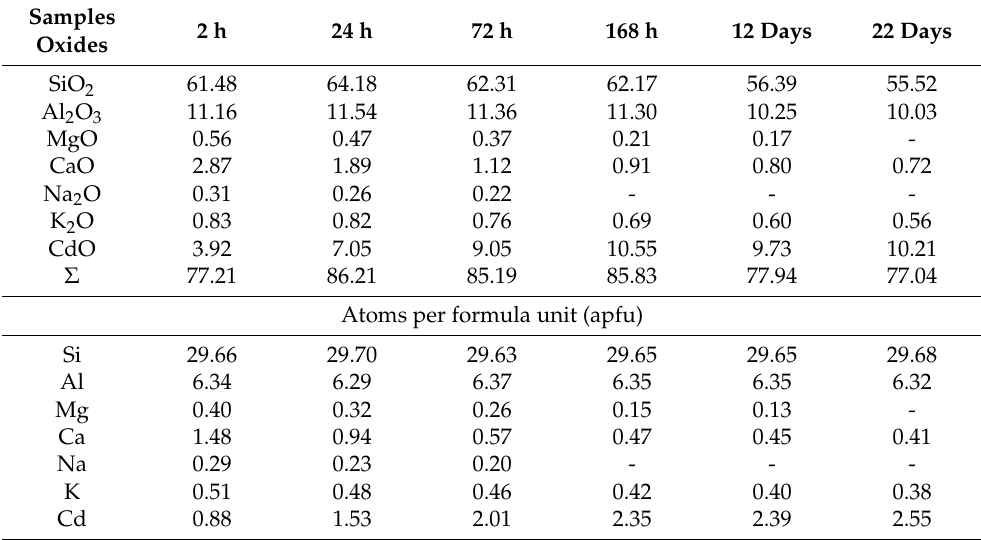
Table 2. Chemical composition (EDS, wt%) and structural formulae of Cd-clinoptilolite (90 ◦ ) based on 72 oxygen